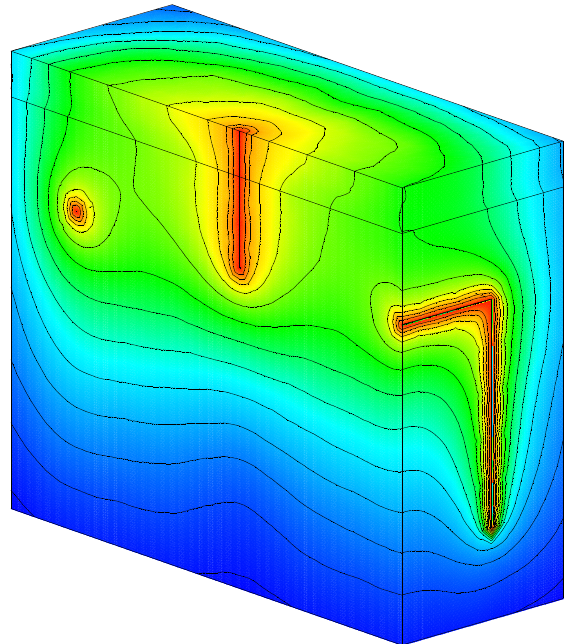
Figure 4. Contours of the potential around the active GS.